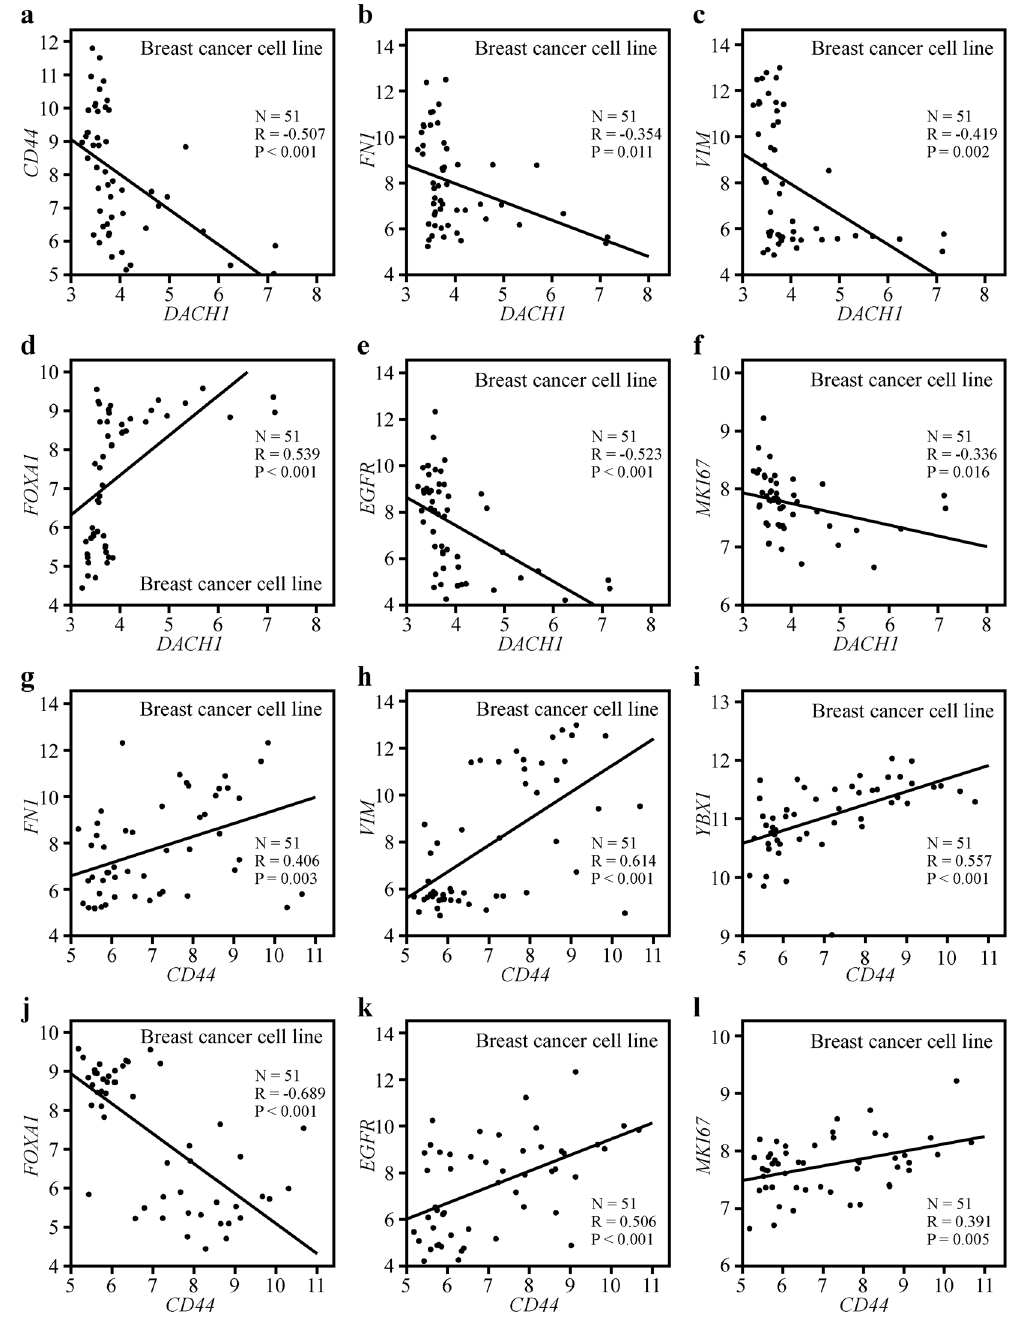
Figure 6. The association between the expression of DACH1 and CD44 with VIM , FN1 , YBX1 , FOXA1 , EGFR and MKI67 in breast cancer cell lines. Correlation analysis of data with a total of 51 breast cancer cell lines showed that DACH1 was inversely correlated with CD44 ( a ), FN1 ( b ), VIM ( c ), EGFR ( e ) and MKI67 ( f ), while positively associated with FOXA1 ( d ). In contrast, CD44 was parallel with FN1 ( g ), VIM ( h ), YBX1 ( i ), EGFR ( k ) and MKI67 ( l ), but negatively related to FOXA1 ( j